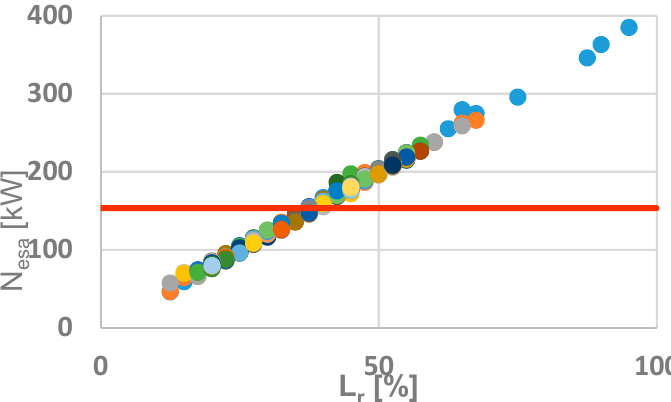
Figure 8. Systematized and averaged values of electrical power over time intervals for the corre- sponding relative loads:—average value of electric power.